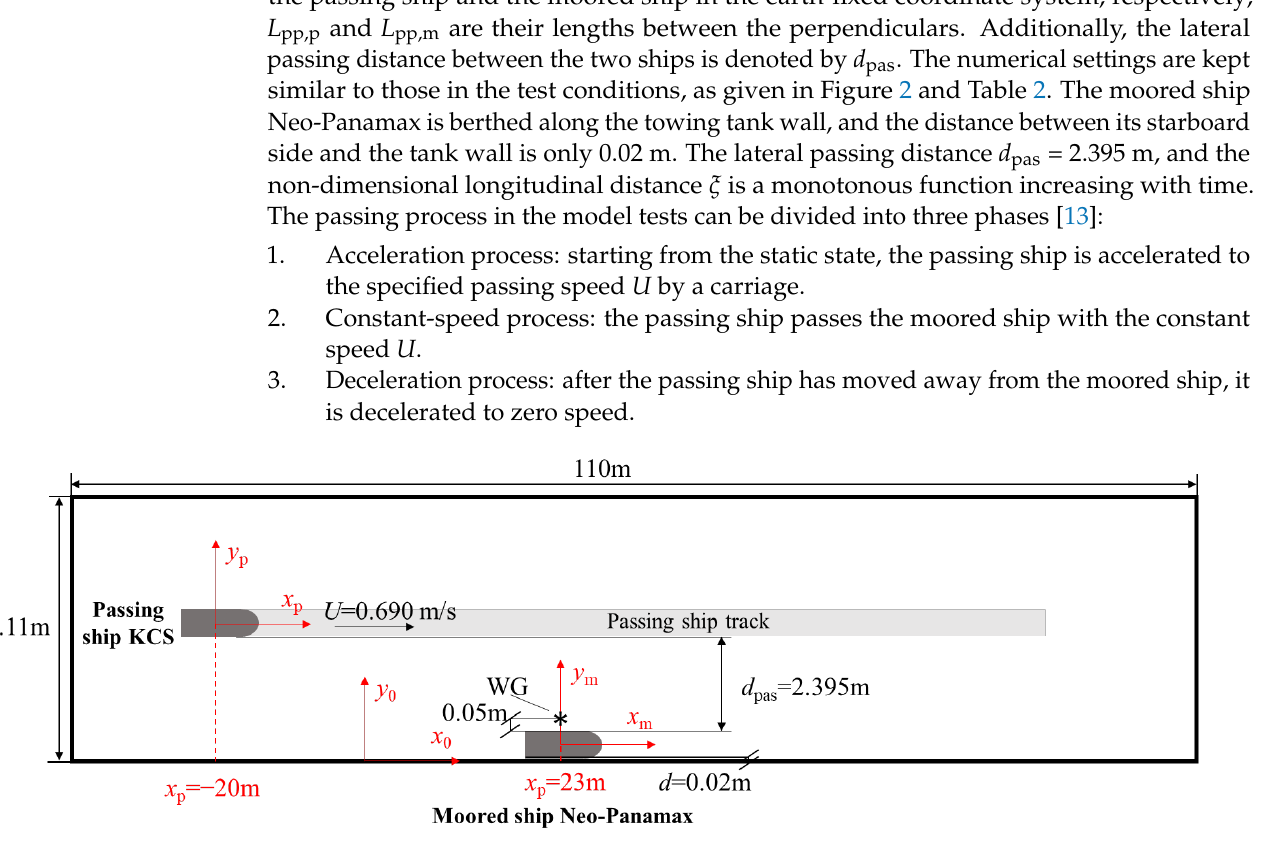
Figure 2. Schematic diagram of test layout and conditions. Table 2. Test conditions.